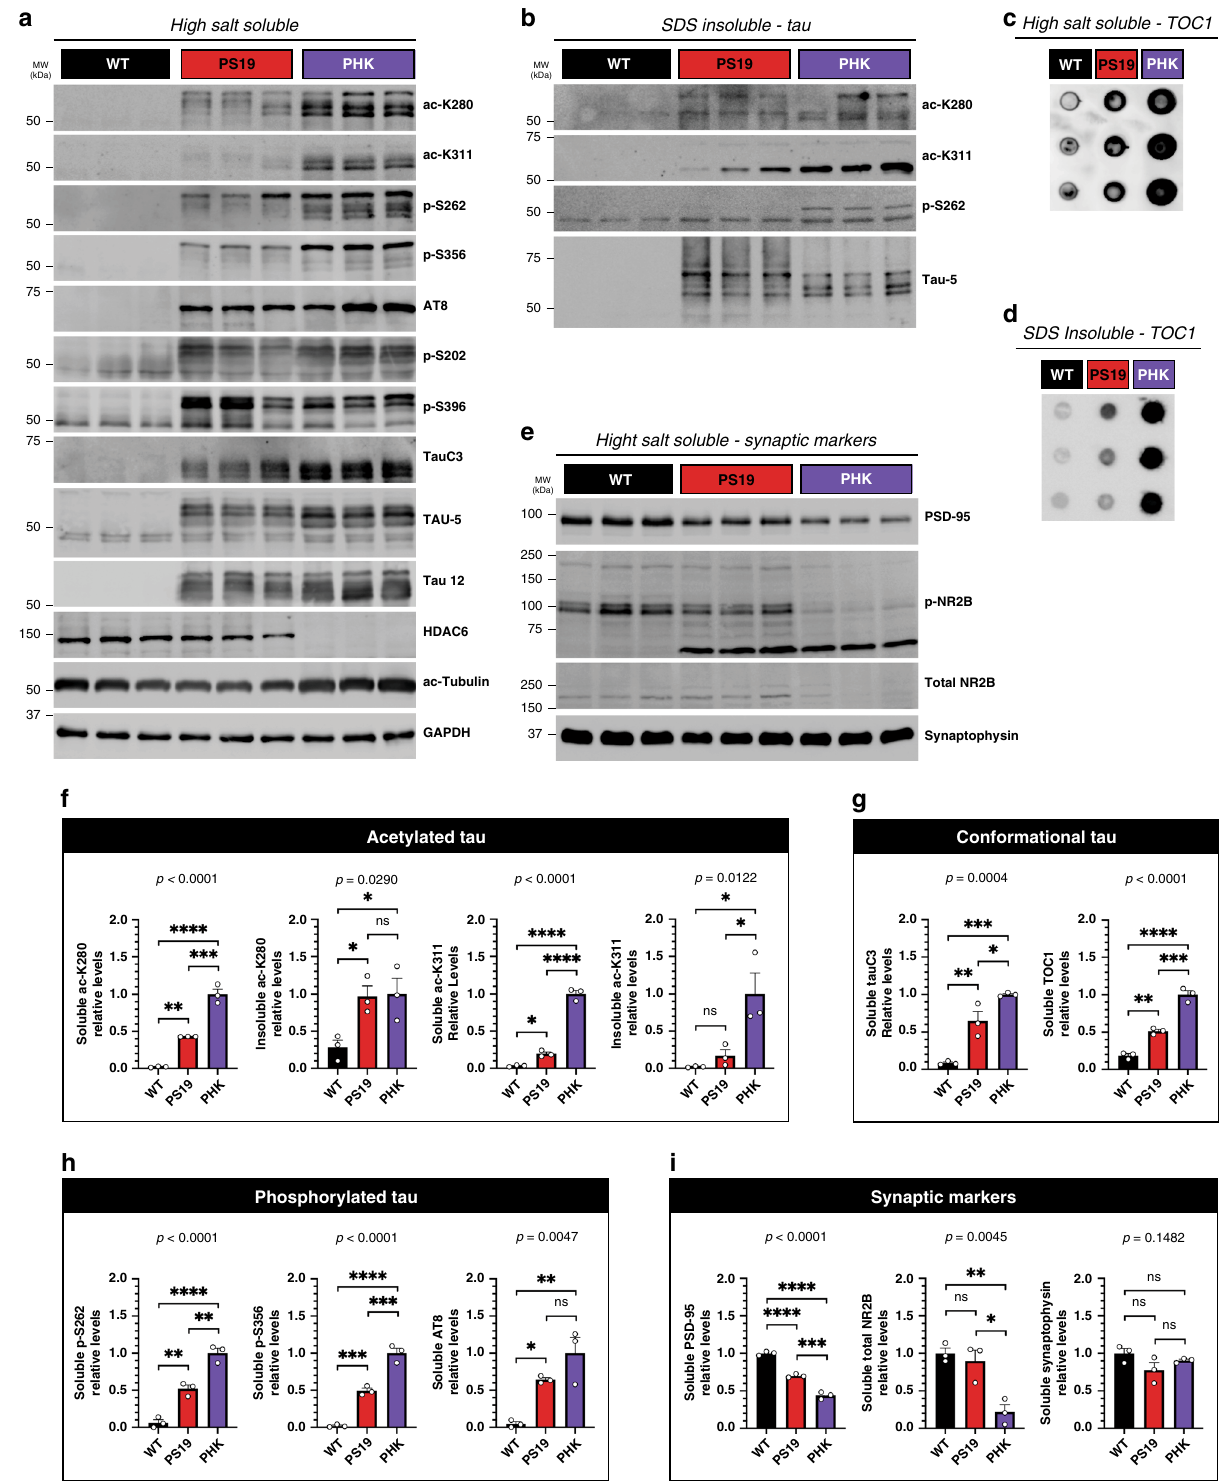
accelerated accumulation of tau pathology in PHK mice reduced postsynaptic (PSD-95), but not presynaptic (synaptophysin), markers (Fig. 7e). Quanti fi cation of the molecular changes in PHK mice is depicted in Fig. 7f – i, which strongly supports loss of HDAC6 as a mediator of tau pathogenesis, synaptotoxicity, and